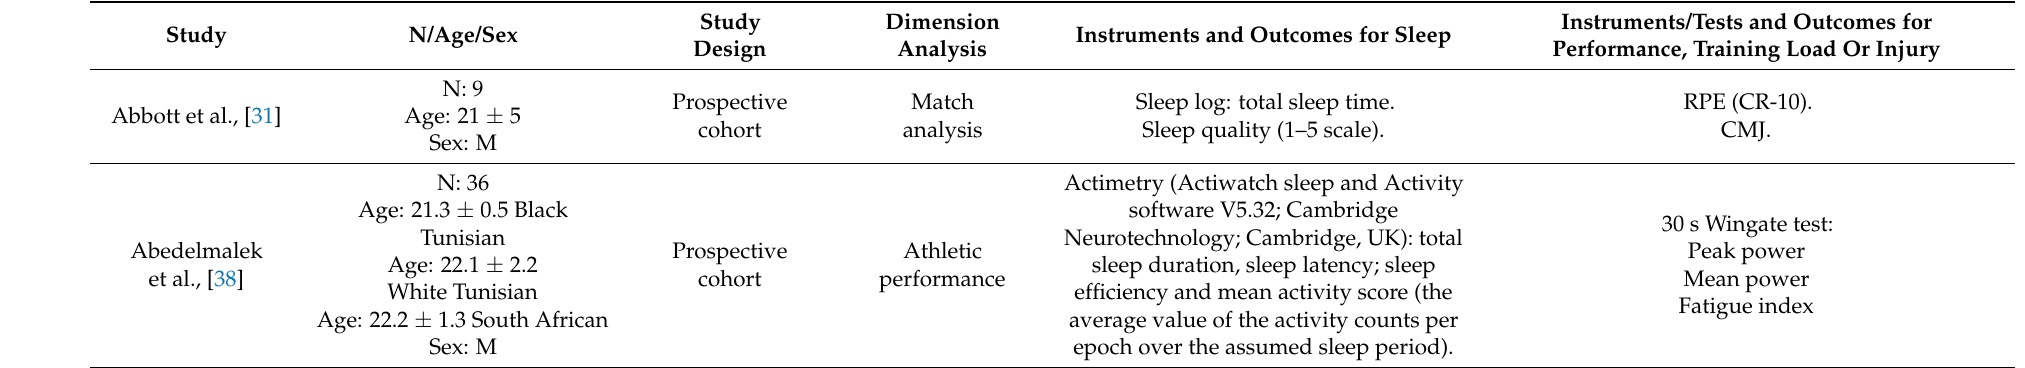
Table 3. Characteristics of individual